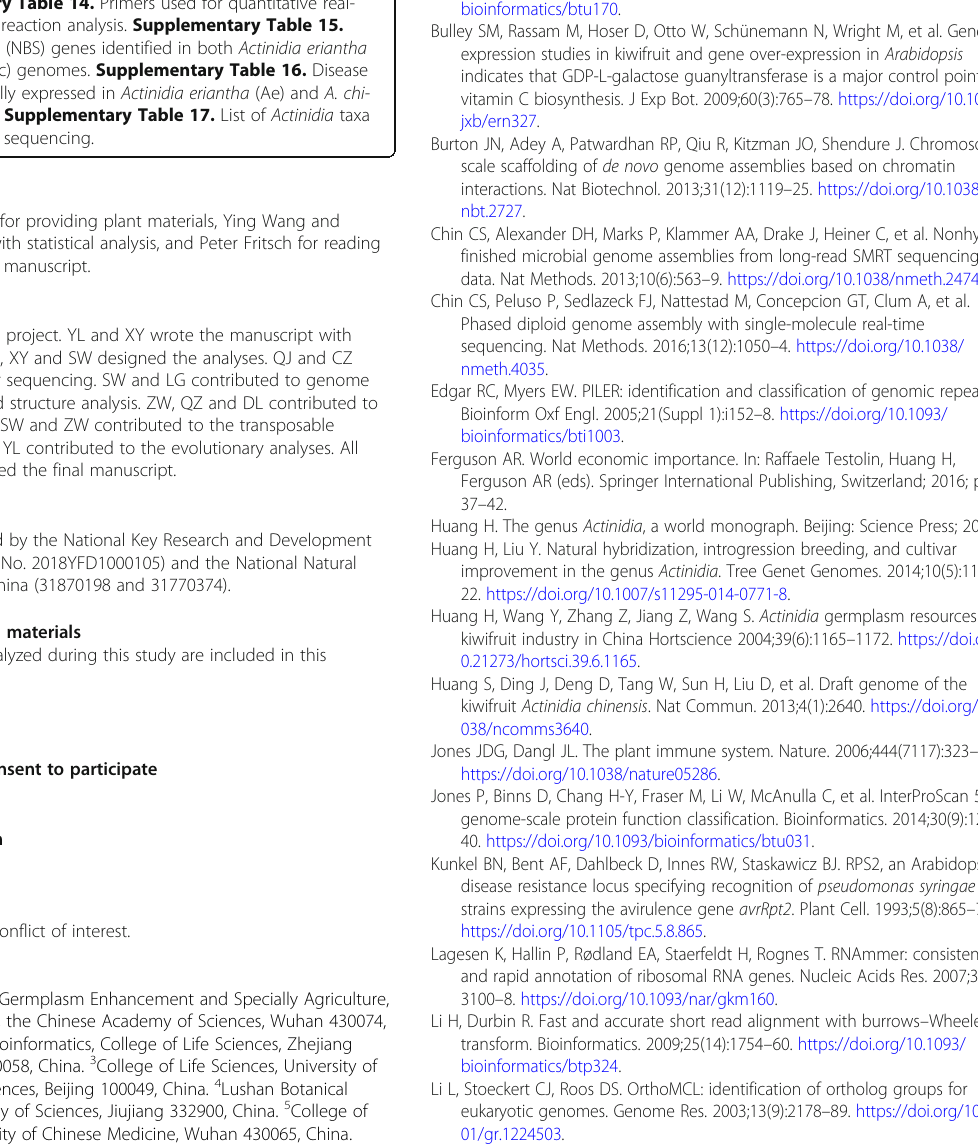
tary Table 1. Genome survey summary based on a k -mer analysis. Sup- plementary Table 2. Summary of the sequencing data of Actinidia eriantha . Supplementary Table 3. Comparison of kiwifruit genome as- sembly statistics. Supplementary Table 4. Summary of scaffolds in each chromosome-scale pseudomolecules. Supplementary Table 5. Asses- sing Actinidia eriantha genome and annotation completeness with BUSCO analysis. Supplementary Table 6. Statistics of genomic repeti- tive contents of Actinidia eriantha . Supplementary Table 7. Classifica- tion of the transposable elements (TEs) in the Actinidia eriantha genome. Supplementary Table 8. Summary of both the intact Gypsy and Copia LTR families. Supplementary Table 9. The identified transcription factor (TF) genes in the Actinidia eriantha genome. Supplementary Table 10. Summary of aligned sequences, SNPs and Indels between Ae and Ac ge- nomes. Supplementary Table 11. Enriched GO terms of the genes spe- cific presented in our Ae genome. Supplementary Table 12. Enriched GO terms of duplicated genes specific presented in both Ad- α and Ad- β events respectively. Supplementary Table 13. Ascorbate-related genes investigated in both the Actinidia eriantha (Ae) and A. chinensis (Ac) ge- nomes. Supplementary Table 14. Primers used for quantitative real- time polymerase chain reaction analysis. Supplementary Table 15. Nucleotide-binding site (NBS) genes identified in both Actinidia eriantha (Ae) and A. chinensis (Ac) genomes. Supplementary Table 16. Disease resistance genes specially expressed in Actinidia eriantha (Ae) and A. chi- nensis (Ac) respectively. Supplementary Table 17. List of Actinidia taxa used for transcriptomic